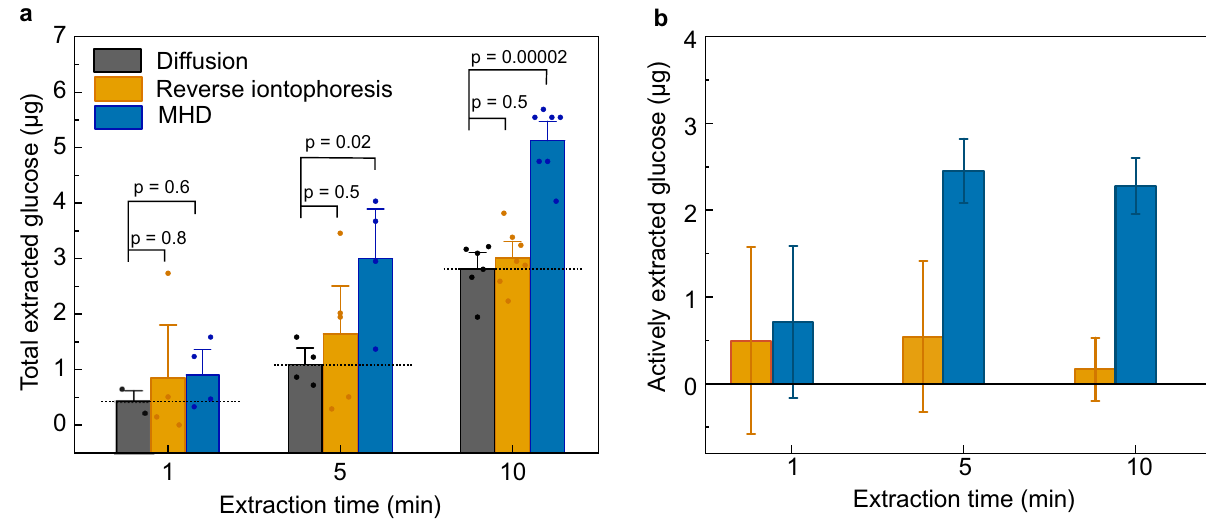
Figure 3. ( a ) The effect of extraction time on total amount of extracted glucose for diffusion, reverse iontophoresis (300 µA) and MHD (300 µA and 300 mT). The bars represent the average from at least 4 individual experiments and the error bars represent standard deviation of the mean. The values of individual experiments are indicated with the circles on top of the bar graphs. Dotted line on the bar graphs serves as a guide for the eye and represent the contribution of diffusion. The p-values were calculated using an unpaired t-test. ( b ) Amounts of actively extracted glucose after the effect of passive glucose diffusion is subtracted. This data indicates that MHD extraction is more effective that reverse iontophoresis also in shorter extraction times. Furthermore, most of the active extraction occurring at the early time points of the